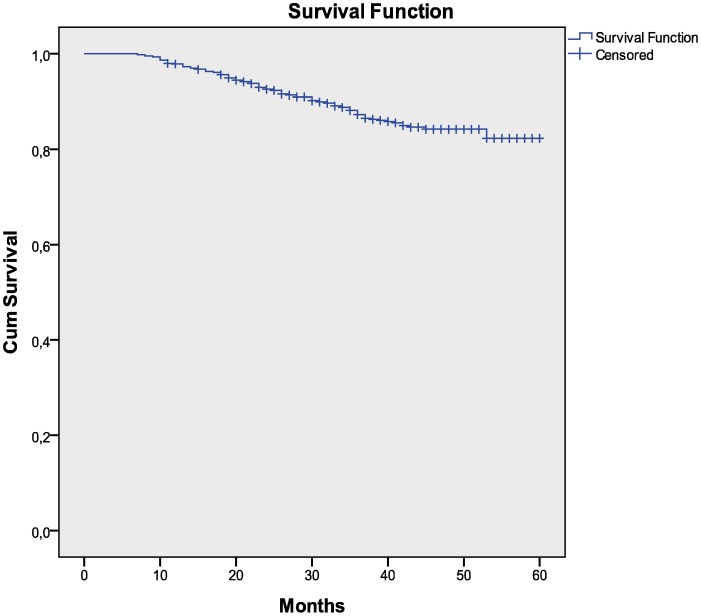
Kaplan Meier analysis from six months of therapy to clinical failure.